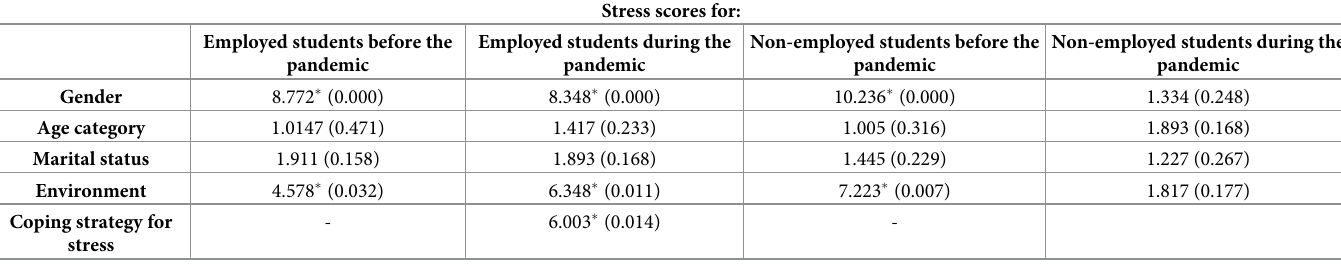
Table 4. The association between stress scores before and during the COVID-19 pandemic and different variables for employed and non-employed nursing students. Stress scores for: Employed students before the Employed students during the pandemic